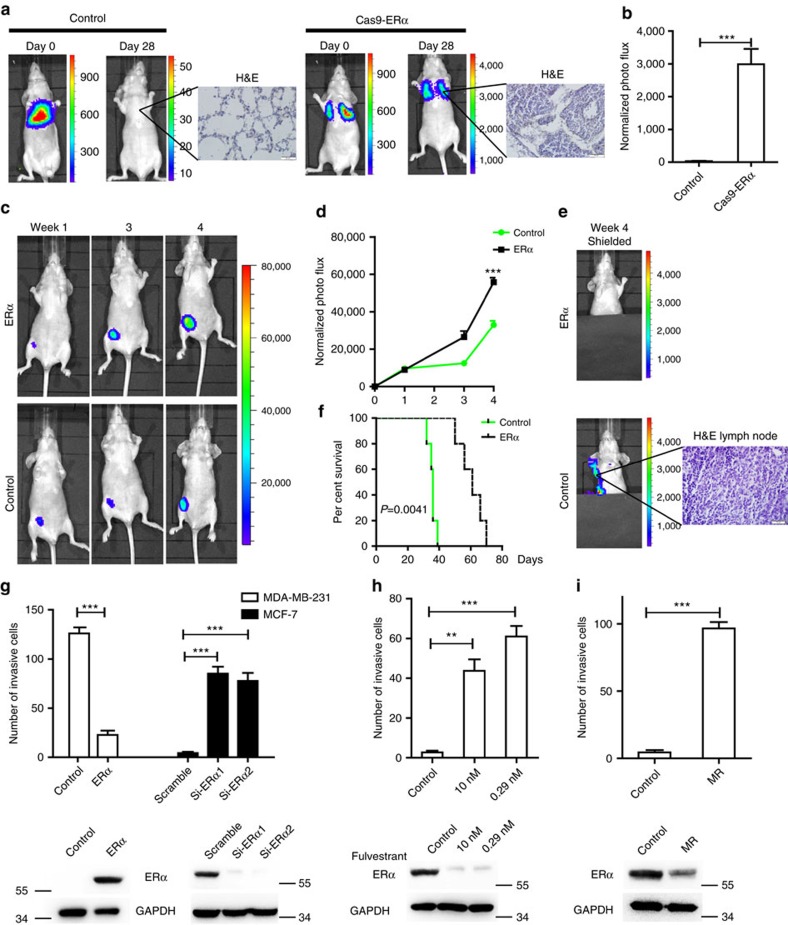
ERα inhibits breast cancer metastasis in vivo and in vitro.MCF-7-luc2 (control) or CRISPR/Cas9-mediated ESR1-deleted MCF-7-luc2 cells (Cas9-ERα) were injected via tail veins into nude mice (n=5). (a) Bioluminescence imaging of the control or the Cas9-ERα group at different time points was used to evaluate tumour progression in the lung. The lung metastases were determined using H&E staining. (b) Luciferase counts of the metastasis sites of mice on week 4. MDA-MB-231-luc2 (control) or ERα-overexpressing MDA-MB-231-luc2 (ERα) cells were injected into nude mice to generate xenograft models (n=5). (c) Bioluminescence imaging at different time points was used to evaluate tumour progression. (d) Luciferase counts of the primary tumours of mice at different time points. (e) Representative images of mice on week 4 are shown after shielding the primary tumour. The lymphatic metastases were determined with H&E staining. (f) The lifetimes of mice injected with control or ERα-overexpressing cells. (g) A transwell assay (top) was performed to determine the effect of ERα on cell invasion by gain or loss of ERα in MDA-MB-231 or MCF-7 cells (n=3). The expression of ERα (bottom) in different groups of MDA-MB-231 or MCF-7 cells was detected by western blotting. (h) A transwell assay (top) was performed to determine the effect of fulvestrant on the invasive capability of MCF-7 cells (n=3). The expression of ERα (bottom) in MCF-7 cells that were processed with fulvestrant of different concentrations was detected by western blotting. (i) A transwell assay (top) was performed to determine the invasive capability of parental MCF-7 and MR cells (n=3). The expression of ERα (bottom) was detected by western blotting. (b,d,g–i) Graphs show mean±s.e.m. **P<0.01,***P<0.001. (b,d,g,i) Unpaired t-test; (f) log-rank test; (g,h) analysis of variance (ANOVA) with Dunnett t-test.